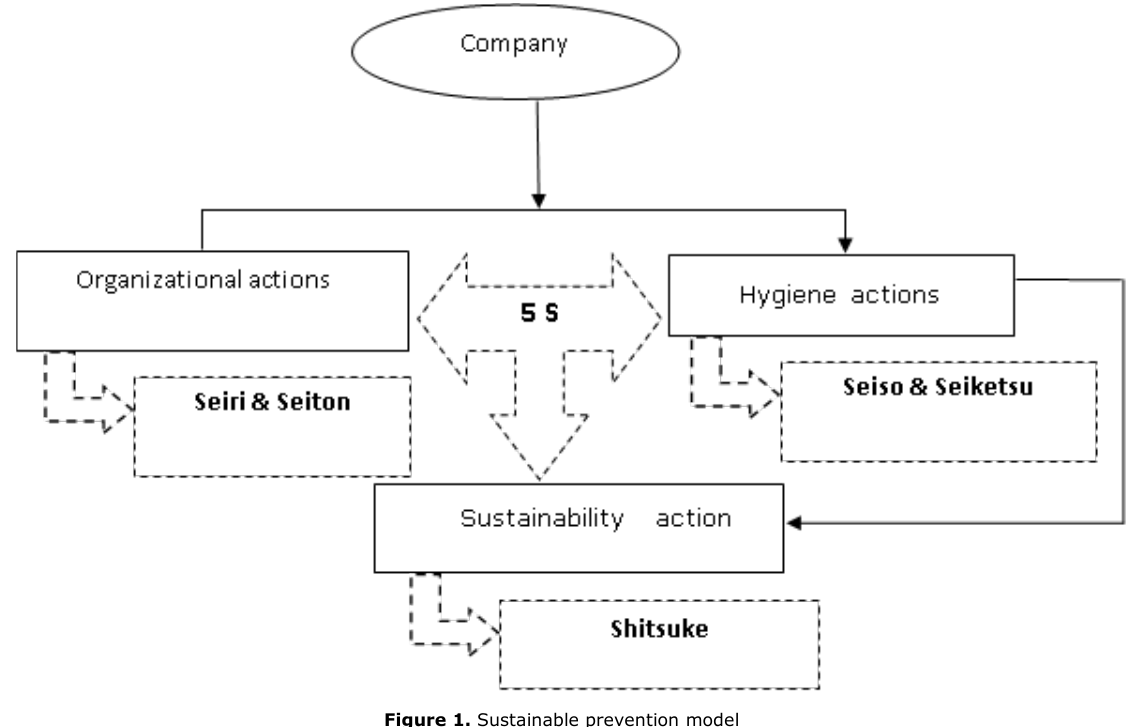
Figure 1. Sustainable prevention